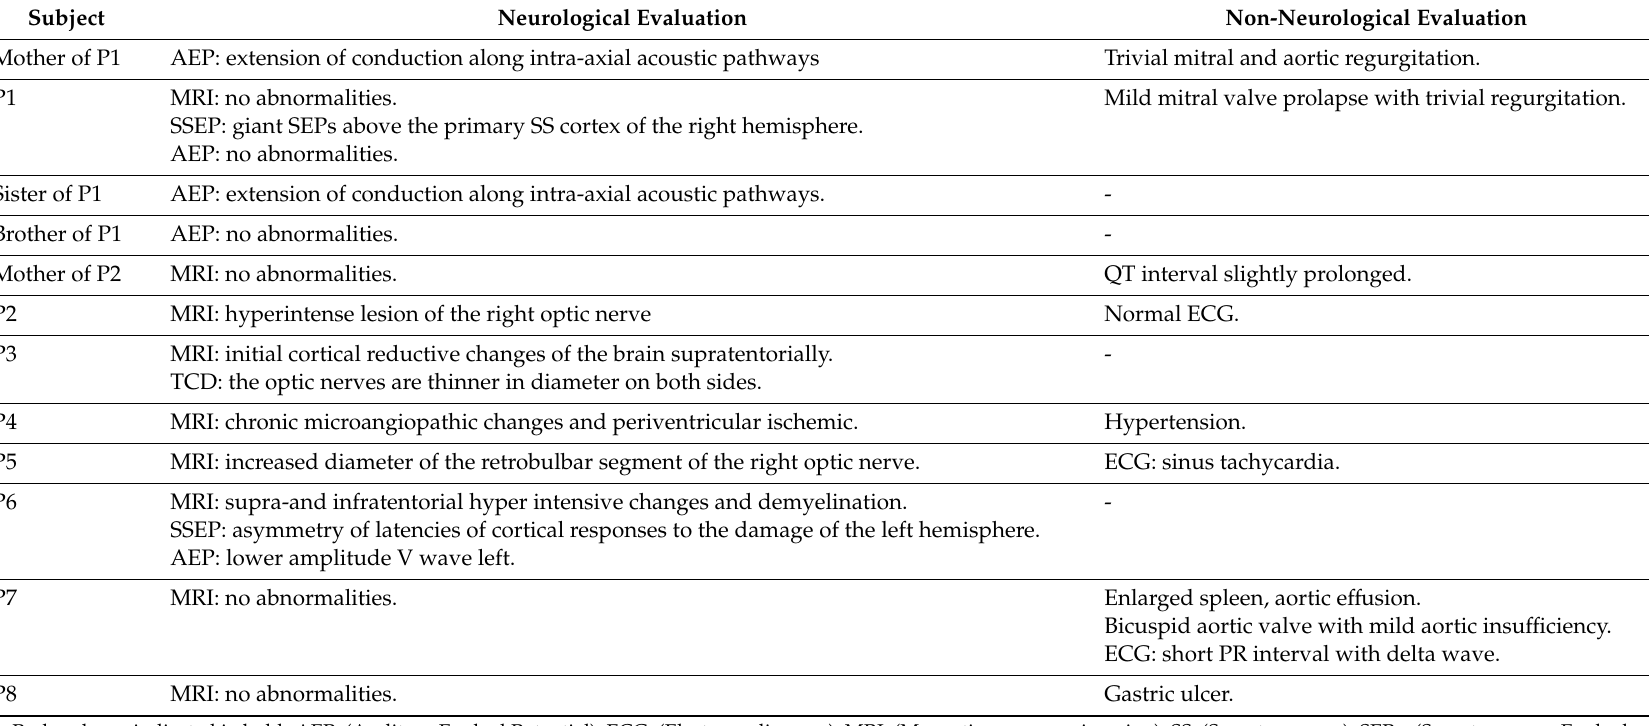
Table 5. Neurological and non-neurological evaluation of LHON in Serbian